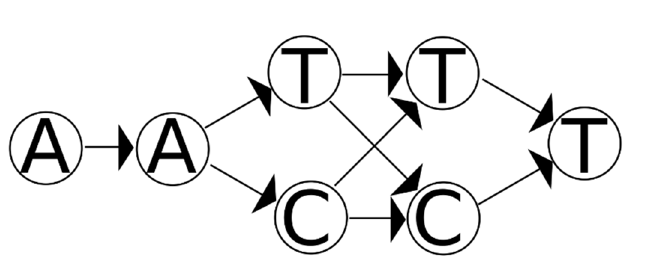
Figure 2. A variant graph for a mixture with two different bases at two adjacent sites. There are four possible sequences that can match this graph (AATTT, AATCT, AACTT, AACCT). All of the nodes in this graph describe sequence data that were in the mixture. Consequently, a suspected set of contributors must (collectively) represent every node in this graph.